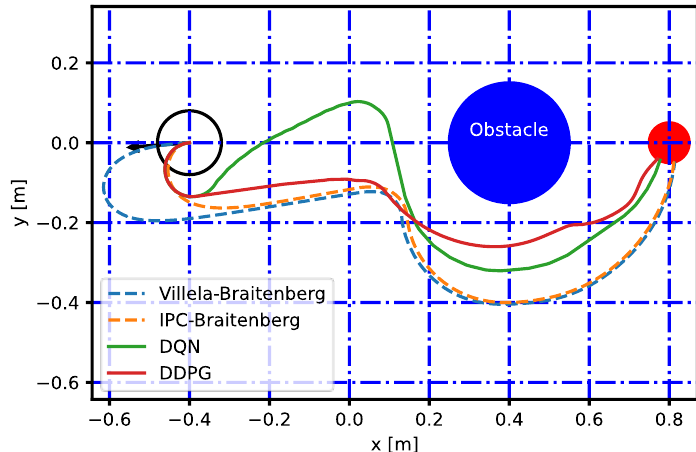
Figure 10. Graph of the trajectory of the experiment with obstacles.